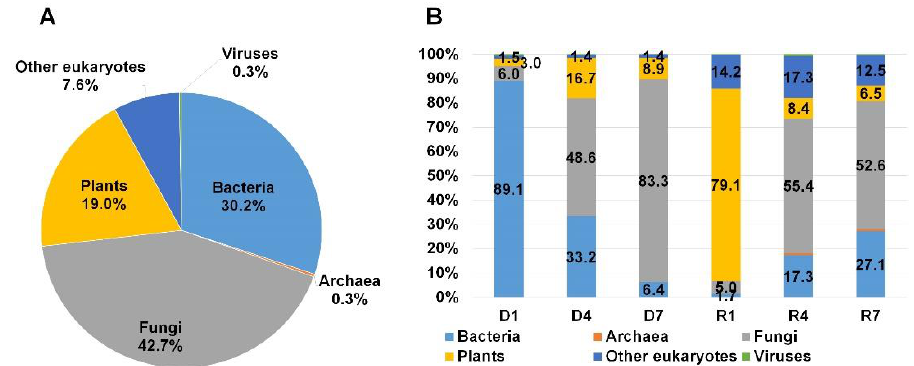
Figure 3. Classification of identified organisms from three mummified peach fruits according to domain. ( A ) Proportion of identified organisms after combining reads from all six different libraries (three DNA and three RNA libraries) based on the number of assigned reads. ( B ) Proportion of identified organisms in each library based on the number of assigned reads. To calculate proportion of identified organisms, we used number of reads assigned to individual organisms identified by MEGAN6 program. The number of reads was not normalized. Three DNA libraries (D1 to D7) and three RNA libraries (R1 to R7) were prepared from S1, S4, and S7 mummified peach fruit samples.